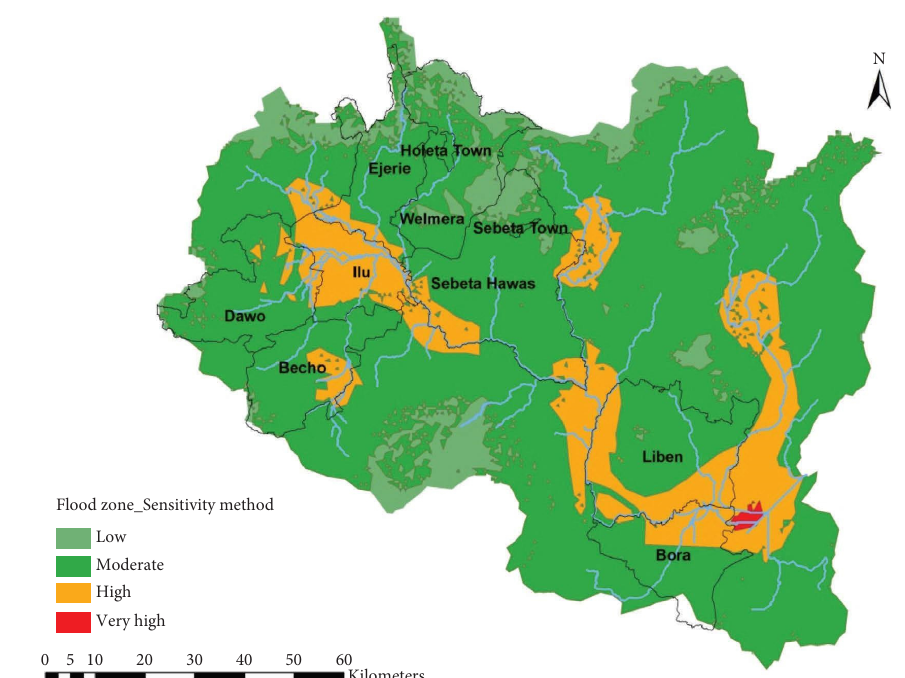
Figure 7: Flood hazard zone developed using sensitivity